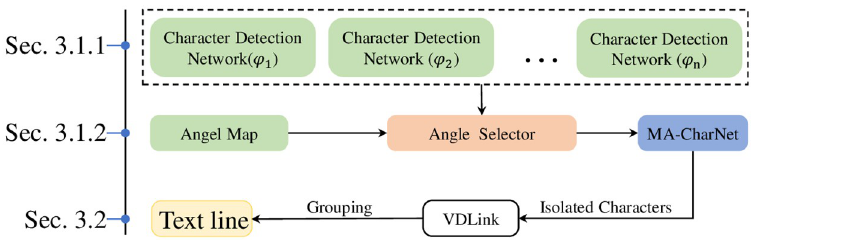
Fig 2. Flowchart of the method